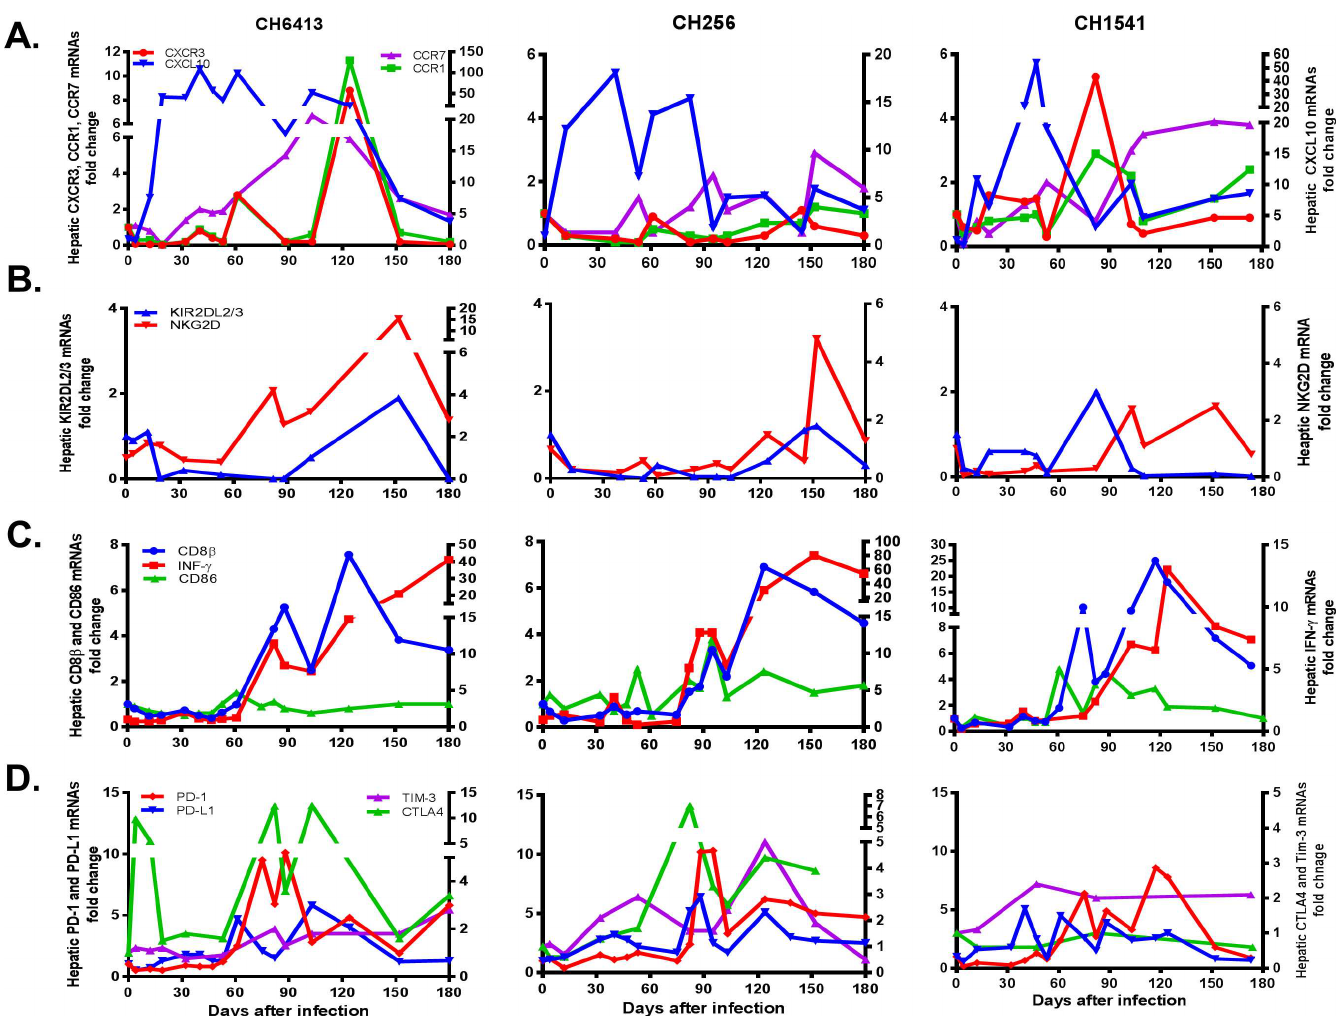
Fig 2. Expression of chemokines, NK cell and T cell co-activation and inhibition markers in liver. (A), Expression levels of chemokine mRNAs in the liver during acute HCV infection: CCR7 (purple line), CCR1 (green line), CXCR3 (red line), and CXCL10 (blue line). (B), Expression levels of NK cell marker mRNAs in the liver: KIR2DL2/3 (blue line) and NKG2D (red line). (C), T cell activation marker RNAs: CD8 β (blue line), IFN- γ (red line), and CD86 (green line). (D), T cell inhibitionmarker mRNA expressionin liver: PD-1 (red line), PD-L1 (blue line), Tim-3 (purple line), and CTLA4 (green line). Each gene’s mRNA level was normalizedto an endogenous reference gene and expressed as an increase over baseline liver tissue